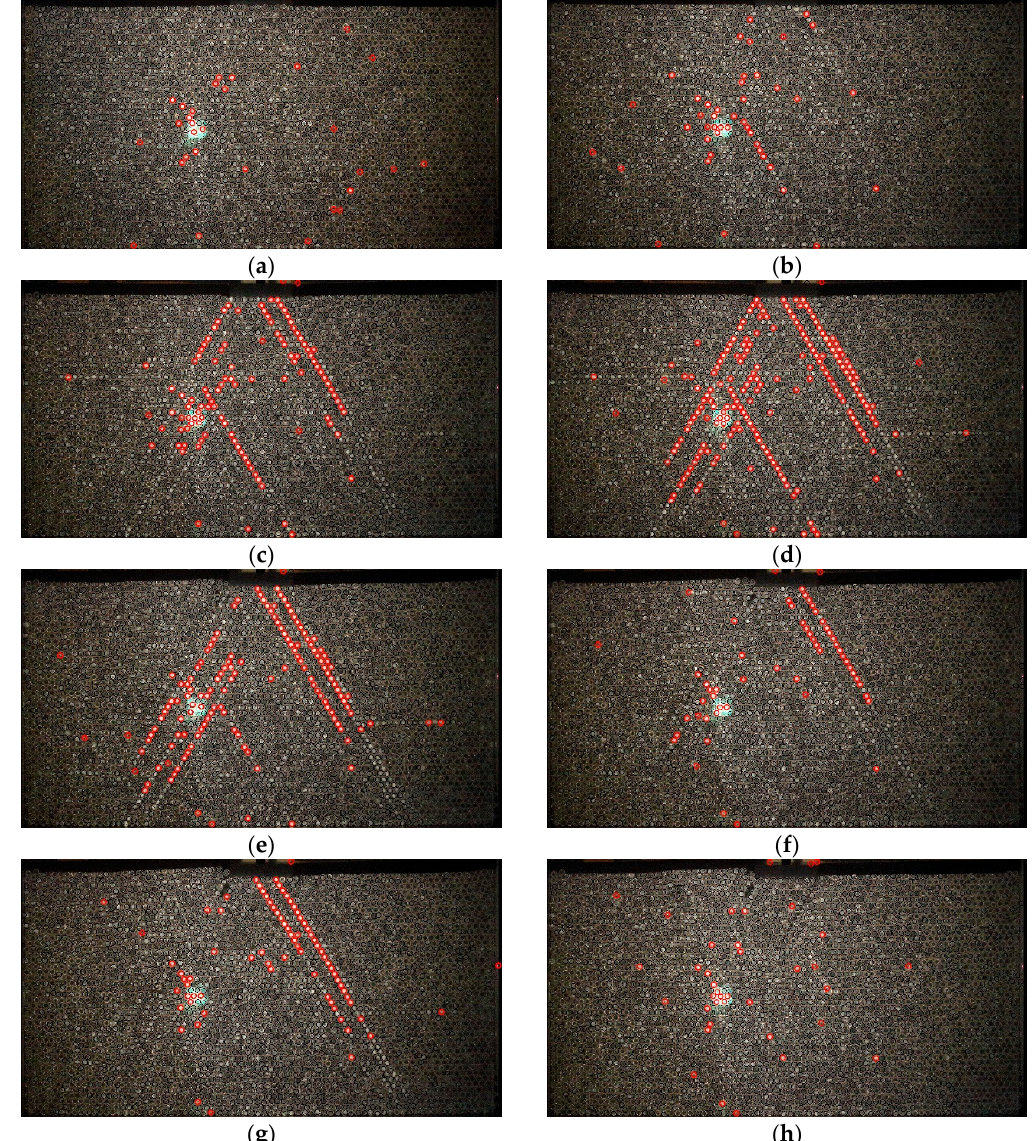
Figure 12. Contact force chains detected by RGB photoelastic digital image analysis during shallow foundation loading: (a) before loading; (b) F = 200 N, d = 5.08 mm; (c) F = 400 N, d = 6.3 mm; (d) F = 600 N, d = 7.21 mm; (e) F = 450 N, d = 7.52 mm; (f) F = 200 N, d = 7.78 mm; (g) F = 3500 N, d = 8.98 mm; (h) F = 20 N, d = 9.81 mm.